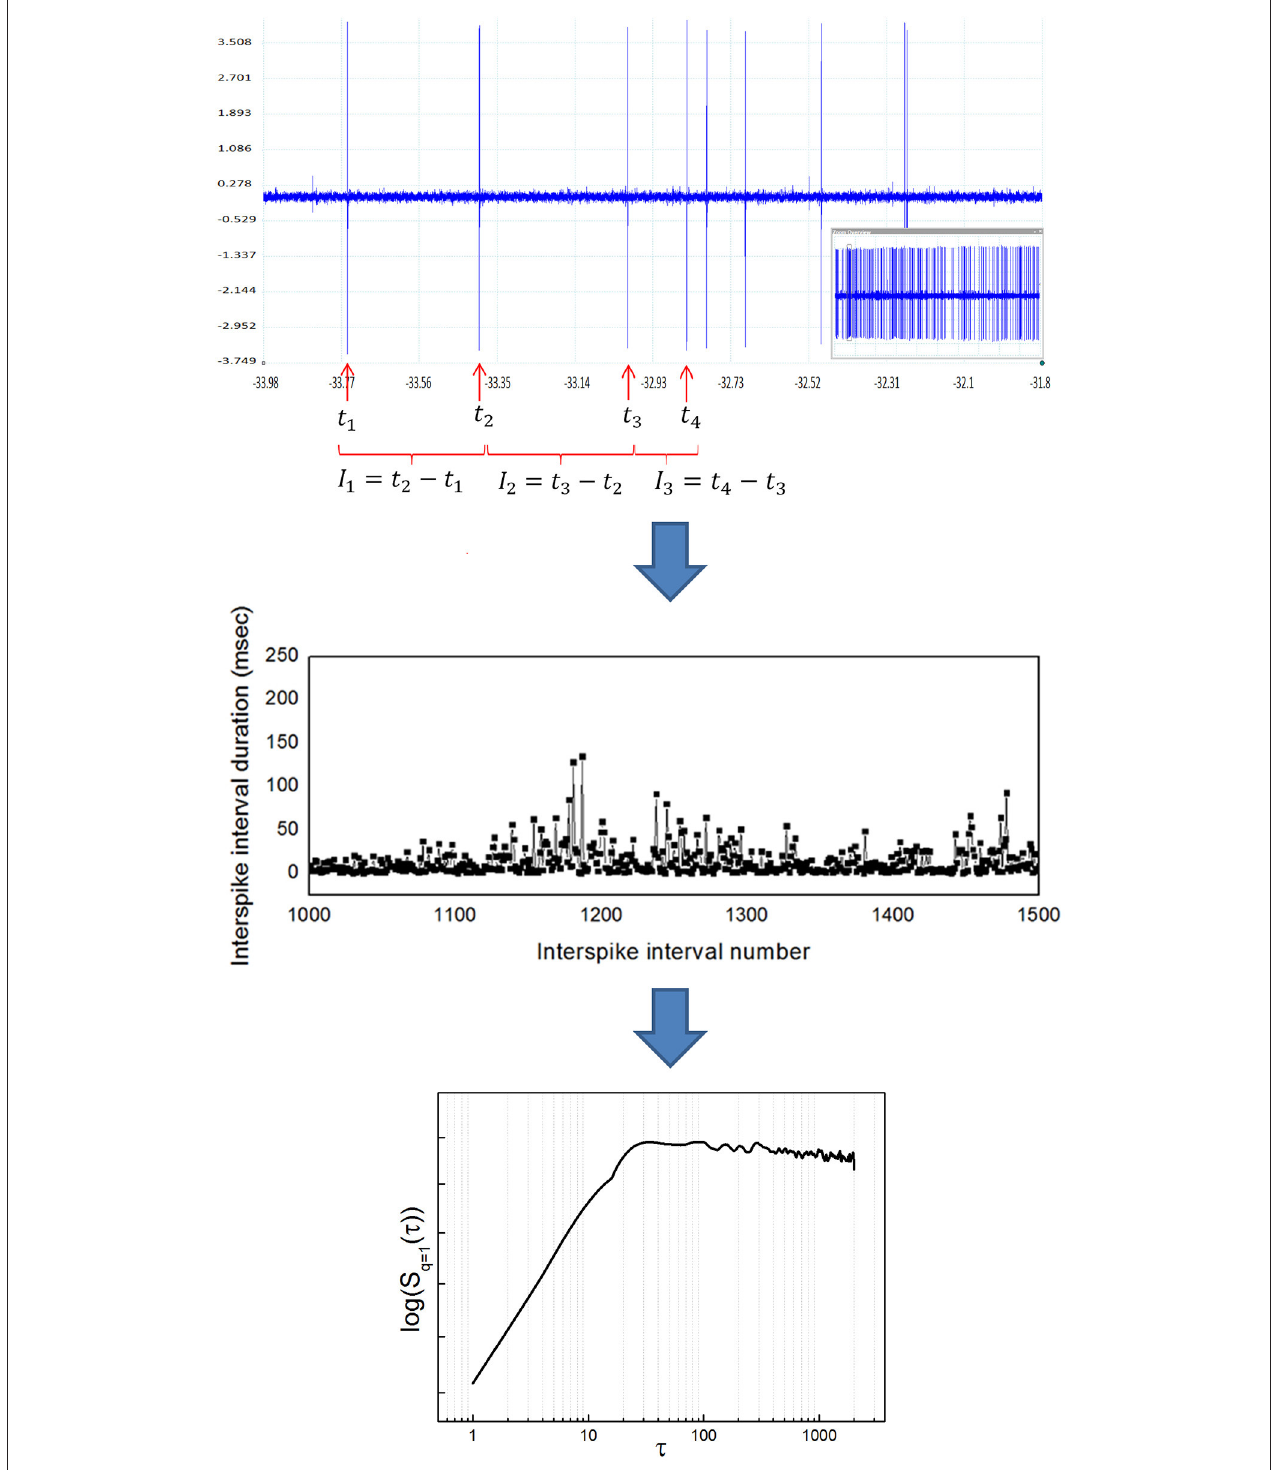
FIGURE 2 | Transformation from a raw neuronal recording into a temporal structure function. (Upper) Sample raw extracellular microelectrode recording of neuronal activity. This recording was obtained from the entopeduncular nucleus of a healthy rat (technical details can be found in Andres et al., 2014a). The vertical axis indicates electric potential (mV) and the horizontal axis indicates time (s). The inlet at the lower right shows the whole recording, from which a zoom is shown in the bigger window. Individual spikes are marked with a red arrow. Once spikes are classified as belonging to a single neuron’s activity, interspike intervals (ISI)